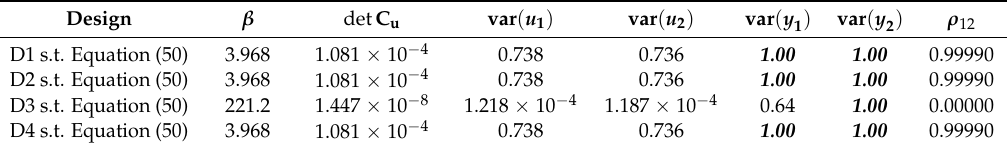
Table 4. Skogestad and Morari column, G 1 ( s ) . Results for different experiment designs. Generalized binary noise (GBN) signals in D3 and D4 are based on switching probability, p sw = 0.05, and mean switching time, E [ T sw ] = 80 min. Active constraints are shown in bold